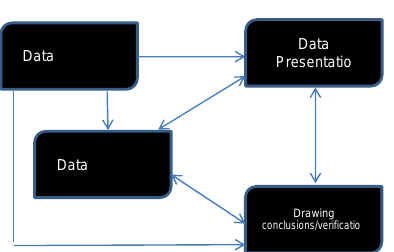
FIGURE 1 | Miles, Huberman and Saldana’s Qualitative Analysis (2014, p.273)